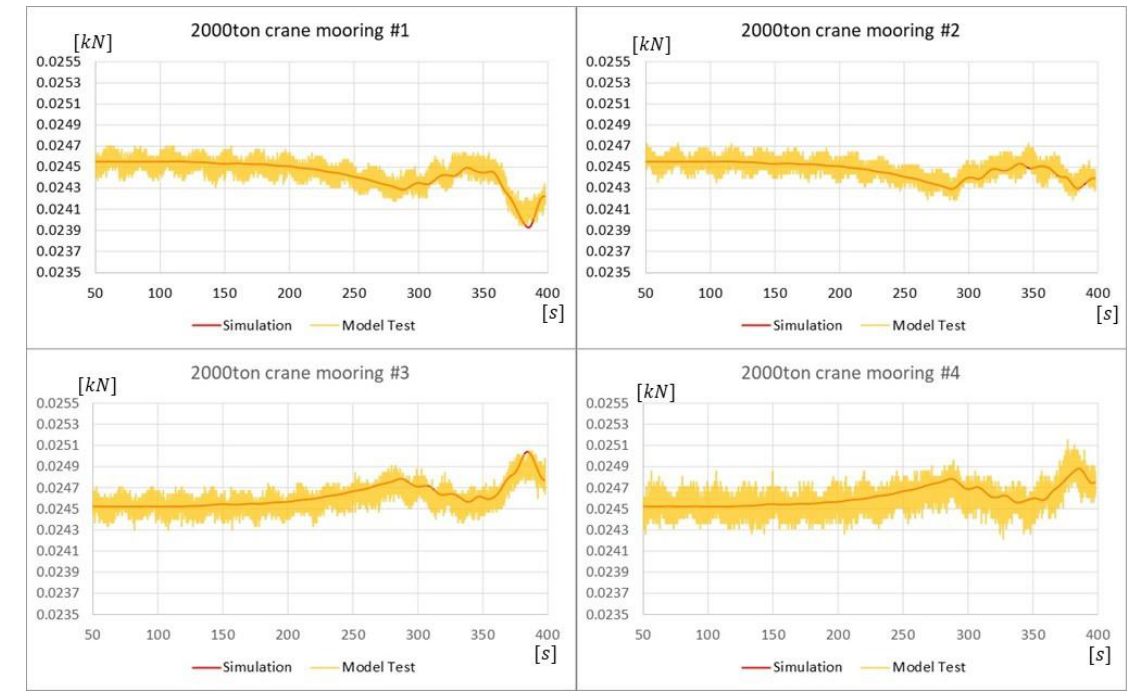
Figure 20. Tension of mooring lines for 2000-ton crane model.